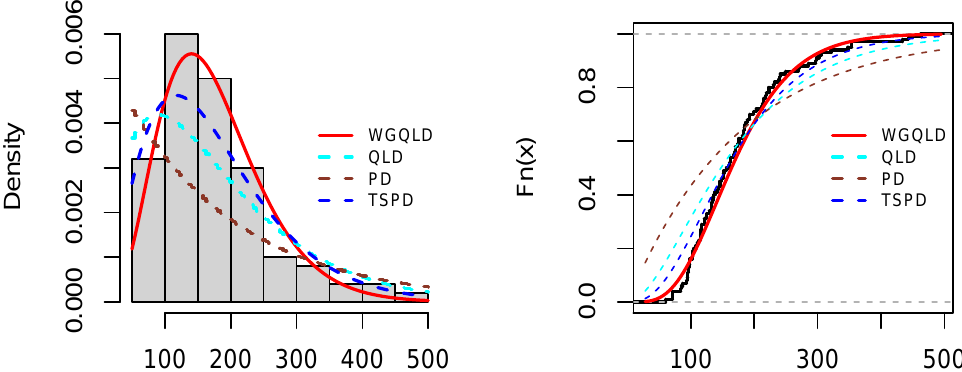
Figure 2. Plots of estimated probability density functions and cumulative distribution functions for rain